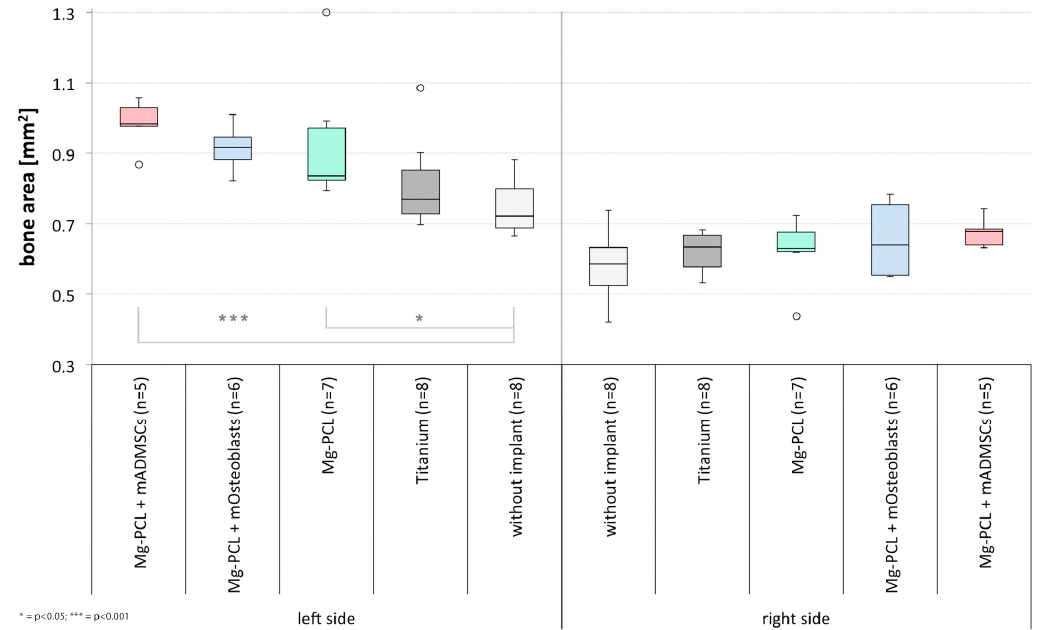
Figure 11. Measured bone area on slides of mice treated without an implant, with uncoated titanium implants, non-previtalised Mg-PCL implants and Mg-PCL implants previtalised with either mOsteoblasts or mADMSCs for both skull halves (* = p < 0.05; *** = p < 0.001; whiskers = minimal and maximal values; horizontal line = median; circles = outliers).